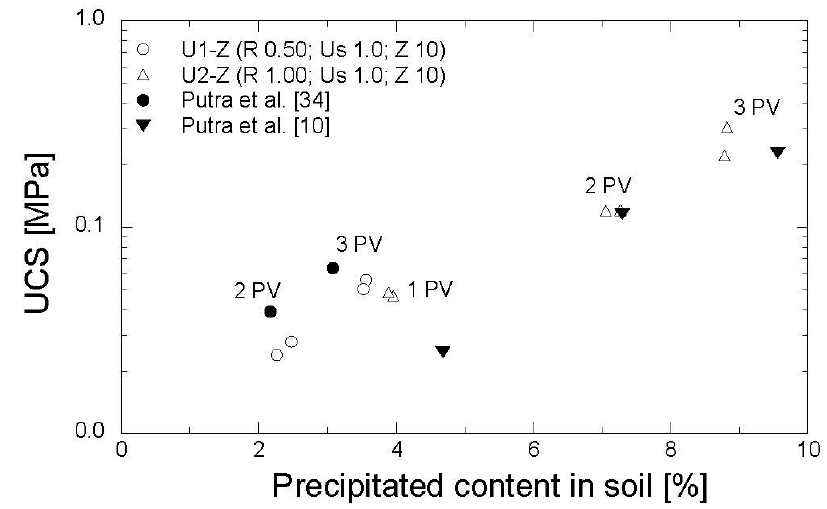
Figure 11. Evolution of strength with precipitated amount.